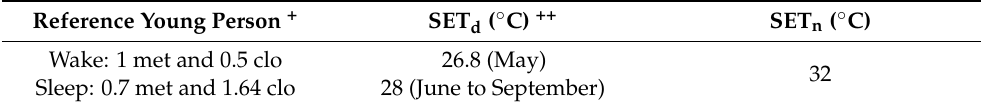
Table 5. Suggested threshold values of SET d and SETn for